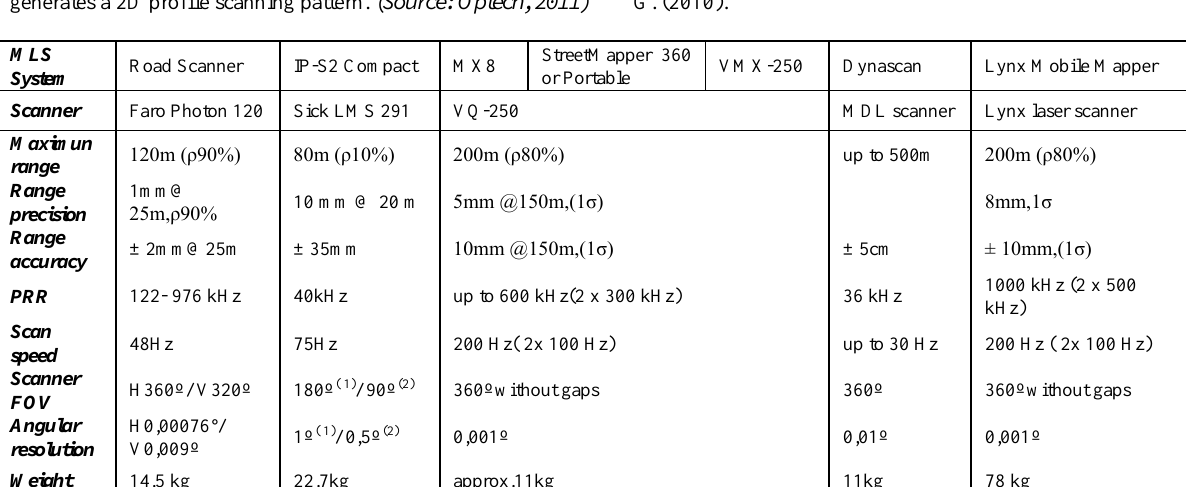
Figure 4. a) Single Laser DYNASCAN Pod. (Source: MDL Laser Systems, 2011) b) The OPTECH LYNX laser scanner that generates a 2D profile scanning pattern. (Source: Optech, 2011)